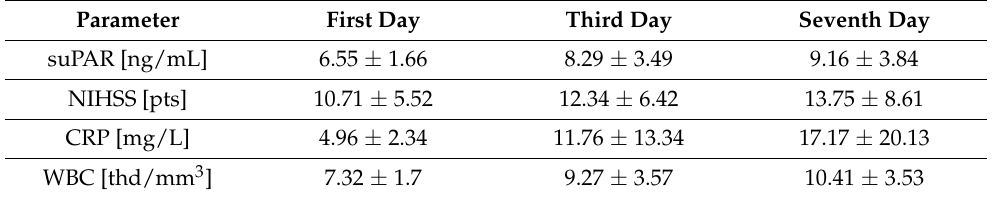
Table 2. suPAR, NIHSS, CRP and WBC values on the first, third and seventh day after ischemic